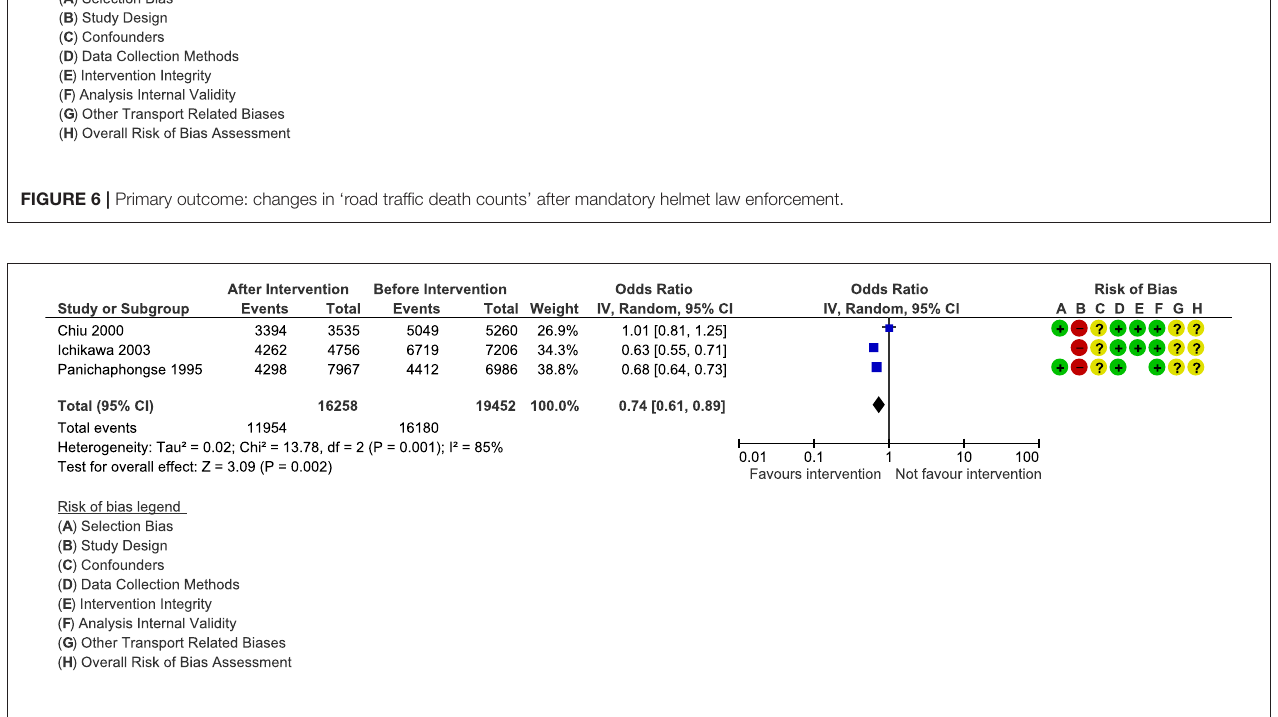
Frontiers in Sustainable Cities |